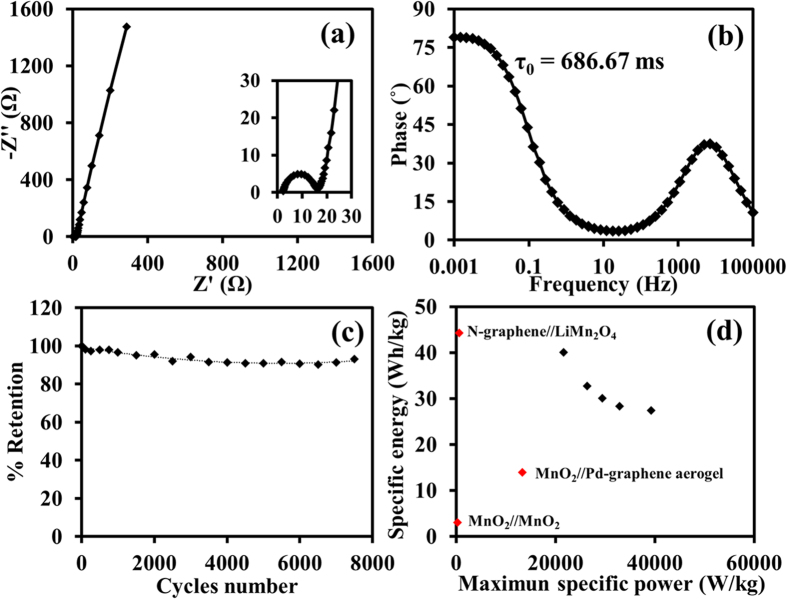
(a) Nyquist plot, (b) phase vs. frequency, (c) capacitance retention over 7,500 cycles, and (d) Ragone plots of the MnO2//N-rGOae supercapacitor compared with other previous work495051.